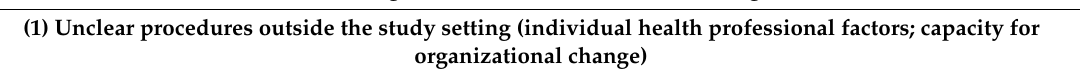
Table 3. Illustrative quotes of emergent barrier themes and their congruent Tailored Implementation for Chronic Diseases (TICD)